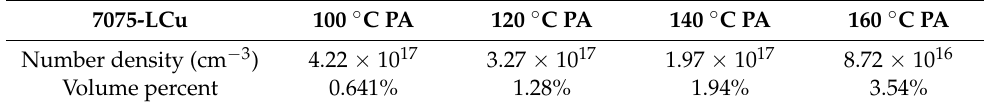
Table 6. Number density and volume percent of 7075-LCu subjected to different PA conditions.